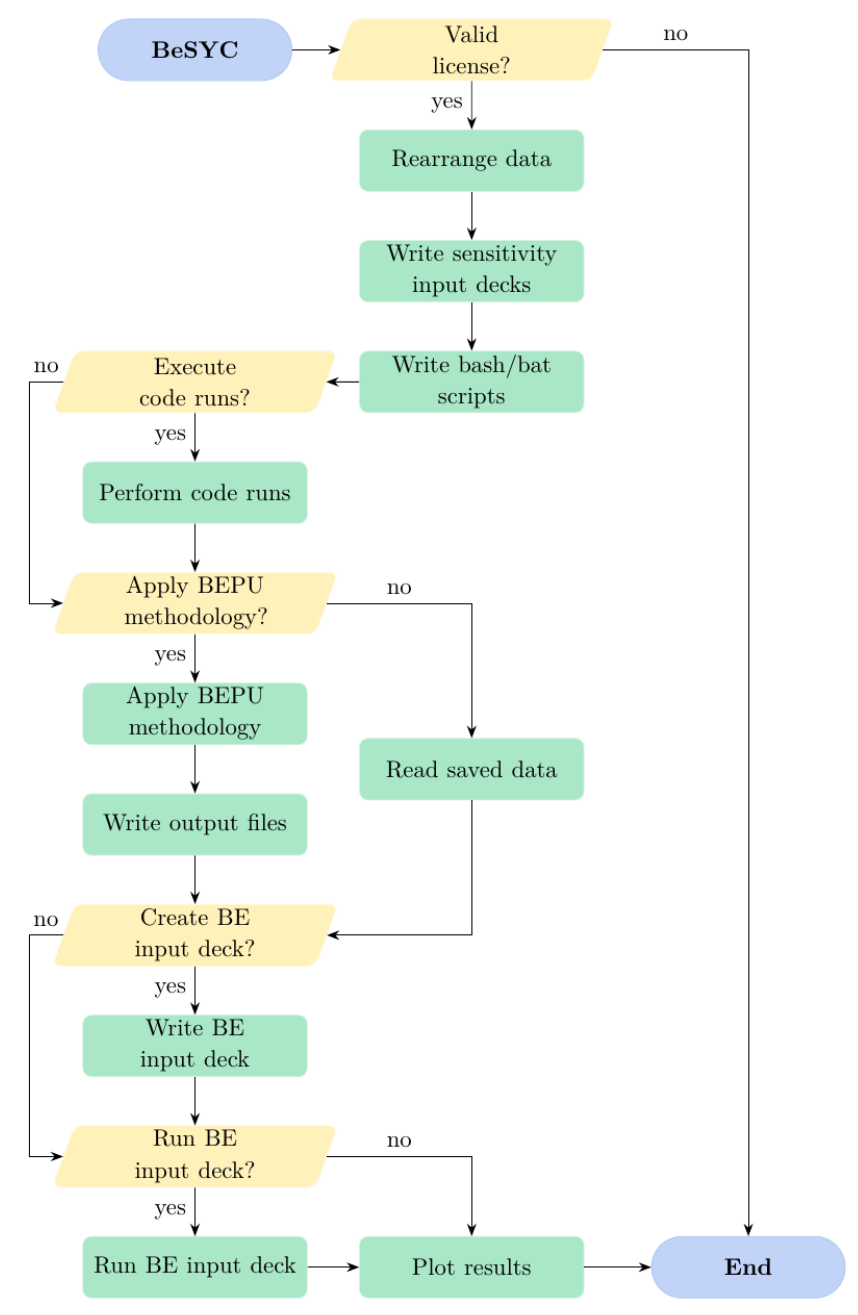
Figure 1. Flowchart of the BeSYC software.